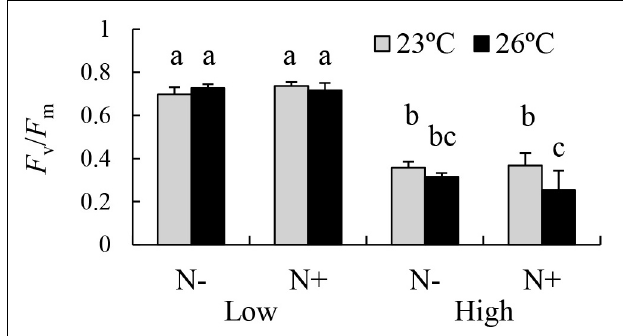
FIGURE 2 | PSII Maximum efficiency ( F v / F m ) of the brown alga E. bicyclis cultured in eight different treatments (mean ± SD, n = 6). N+ and N– indicate nutrient-enriched and non-enriched treatments, respectively. Low and High indicate low and high irradiance treatments, respectively. Different small letters indicate significant differences among different treatments.